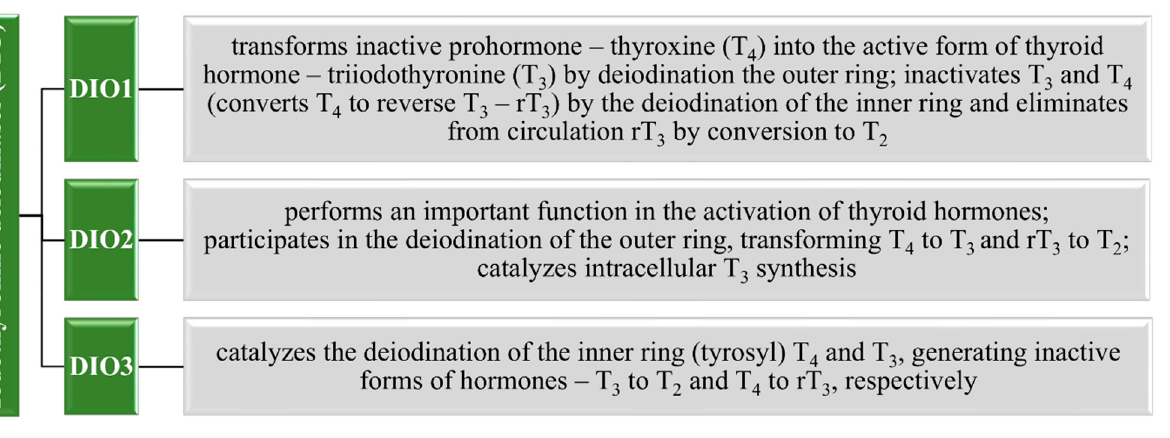
Figure 5. Selenoproteins of the iodothyronine deiodinases (DIO) family and their functions [114,115,117–119].